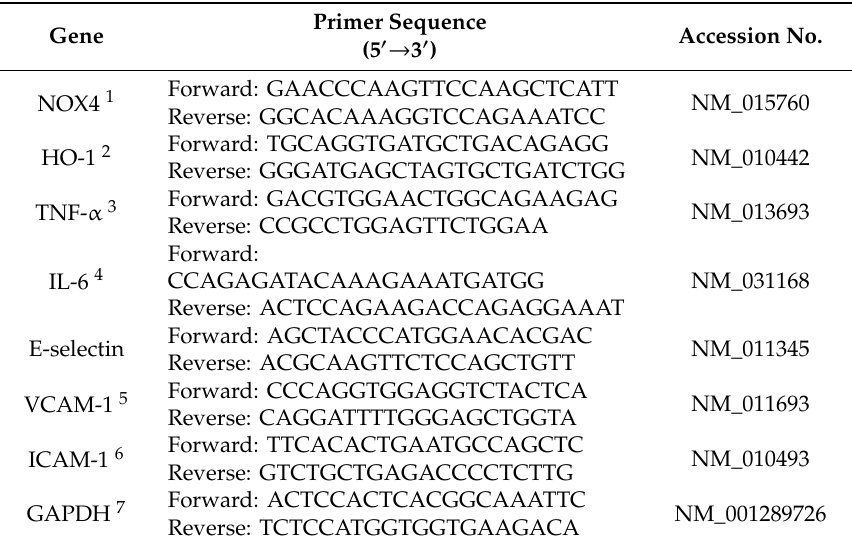
Table 1. List of primers used in this